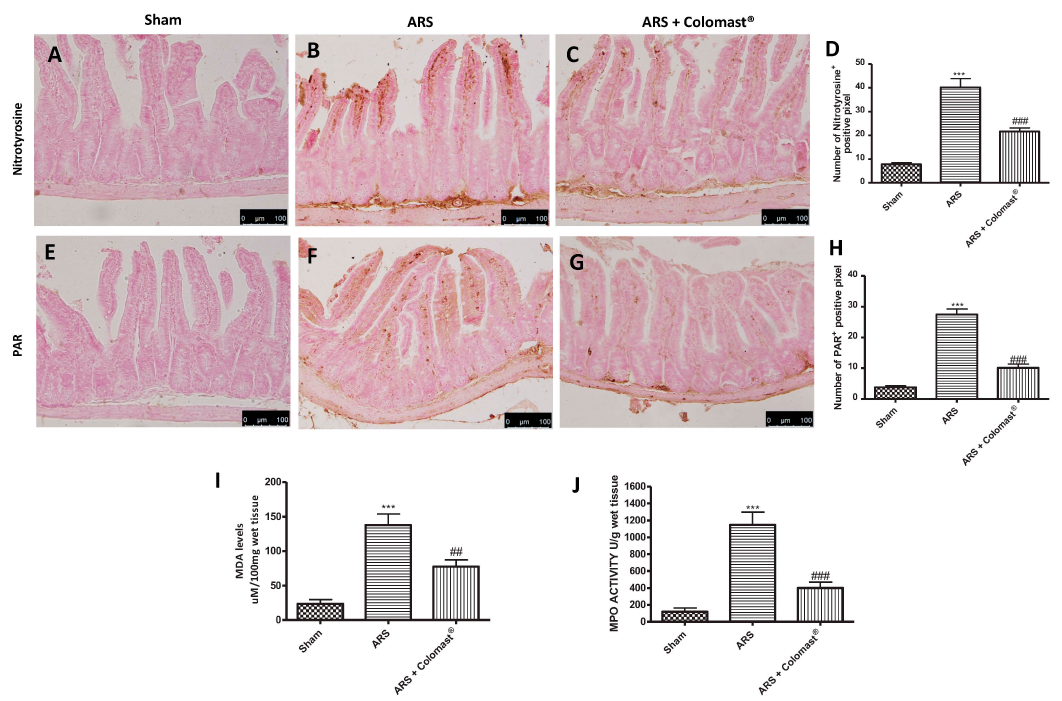
Figure 6. Effect of Colomast ® pre-treatment on nitrotyrosine formation, PARP activation, MPO activity, and lipid peroxidation in ileum. Immunohistochemistry evaluation of nitrotyrosine expression: sham ( A ), ARS ( B ), and Colomast ® ( C ). Immunohistochemistry evaluation of PARP expression: sham ( D ), ARS ( E ), and Colomast ® ( F ). Graphical quantification of nitrotyrosine ( G ) and PARP ( H ) expressions. MDA levels in ileum tissue ( I ). MPO activity in ileum tissue ( J ). Images are figurative of at least three independent experiments. Values shown are means ± SEM of six animals in each